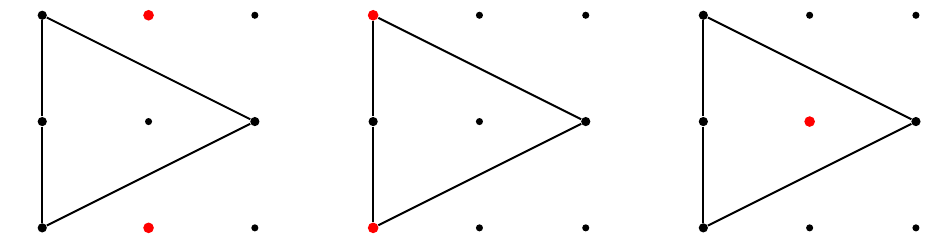
Figure 26. The three toric orientifold projections on the toric diagram. The right one is performed by an (cid:10)3 plane, while the one on the left a non-compact (cid:10)7, on the right a compact (cid:10)7.